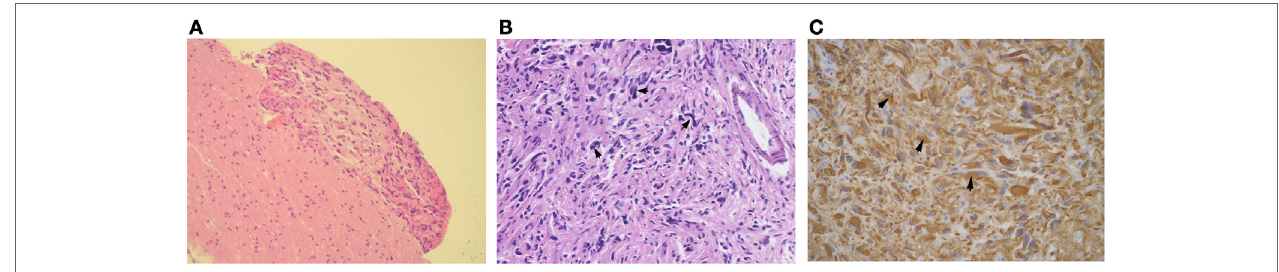
FIGURe 4 | Histological examinations of a specimen obtained in left temporal lobe. Tumor tissue was localized along the cerebral meninges (HE stain, 100 × ) (a) . Spindle-shaped tumor cells with pleomorphic hyperchromatic nuclei and an increased mitotic rate spread in the subarachnoid space (B) (200 × ). The glial fibrillary acidic protein stain was strongly positive in the cytoplasm of tumor cells (C) (400 ×